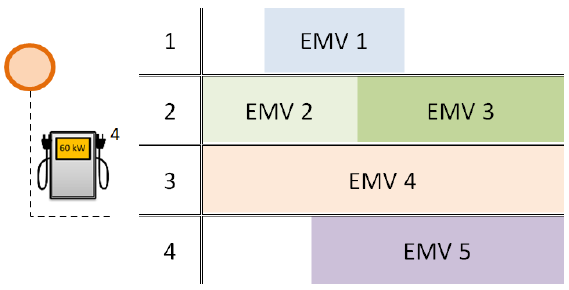
Figure 7. Gantt chart of a feasible solution which “the station as a charging point” rule treats as the infeasible one.